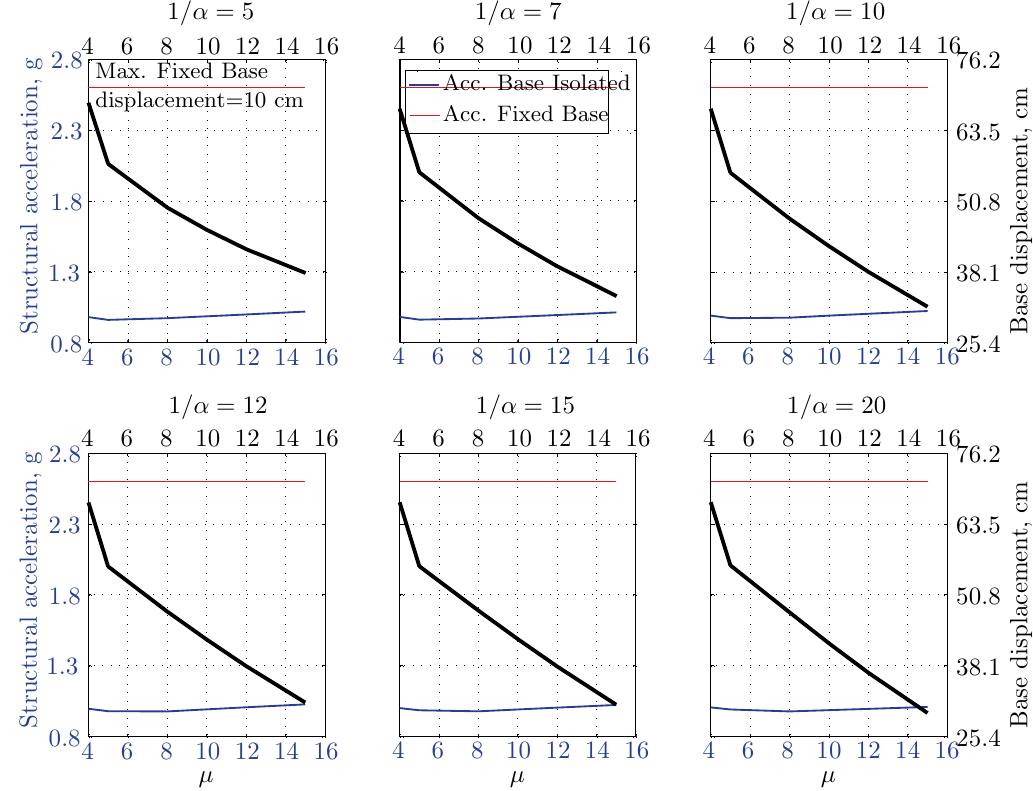
Figure 38. Peak responses of BI-structures subjected to Northridge 1994 (Sylmar station).